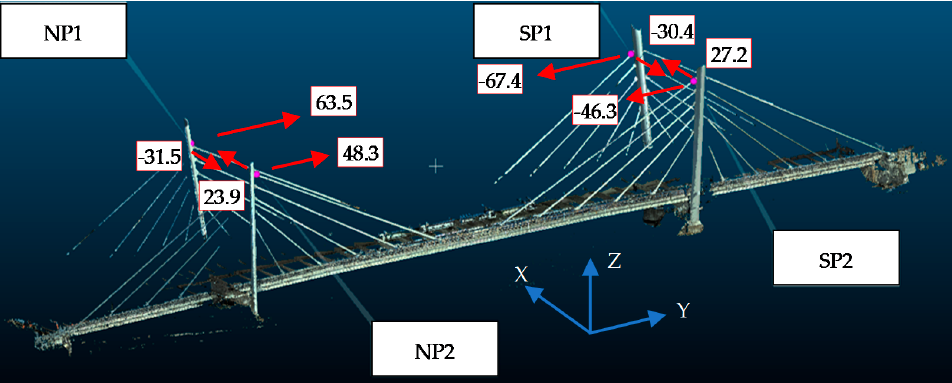
Figure 12. Laser scanner point cloud that was acquired during C1. Table 3. Comparison between the experimental and numerical displacements of the investigated pylon points in C1 load configuration. Longitudinal Displ. (Y) [mm] Point